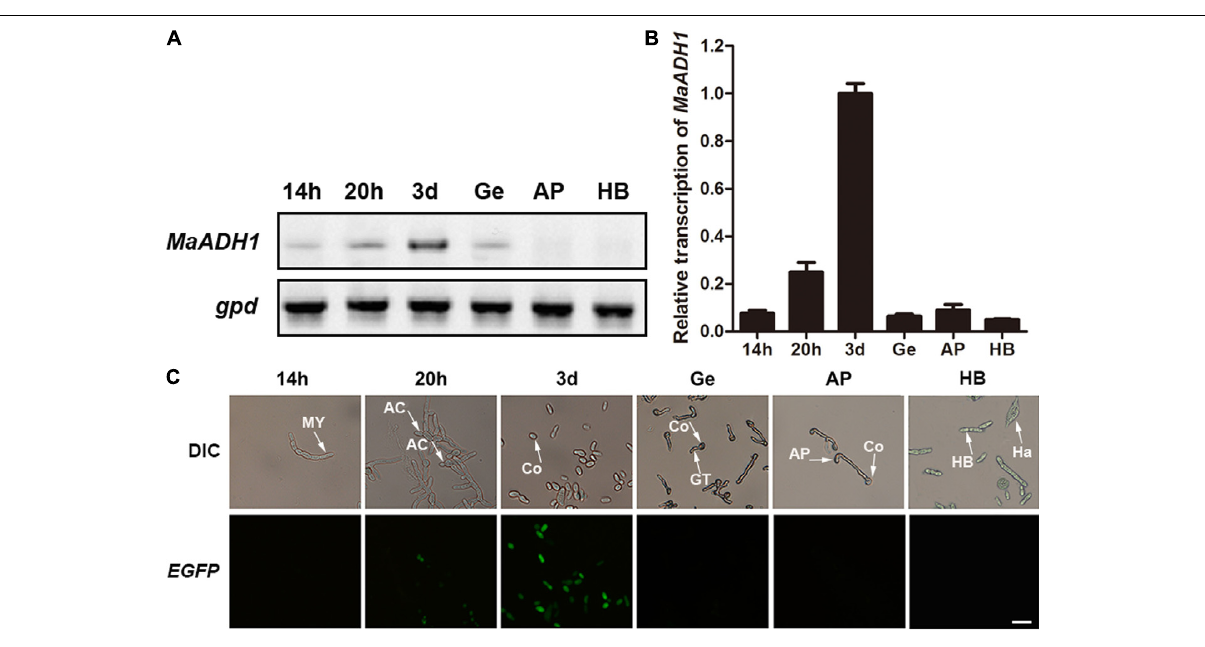
FIGURE 2 | Expression pattern of MaADH1 by semi-quantitative RT-PCR (A) and qRT-PCR (B) analysis of transcription of the MaADH1 gene on different life stages. (C) Fluorescence of MaADH1-EGFP in different stage. Ge, germination; AP, appressorium; HB, hyphal body; MY, Mycelium; AC, Arthroconidia; Co, conidia; GT, germ tube; Ha, hemocyte. Scale bar = 10 µ